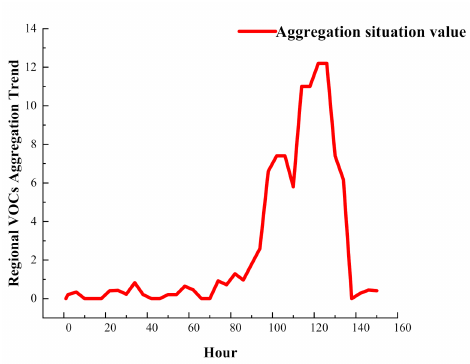
Figure 5. VOCs trend of the situation